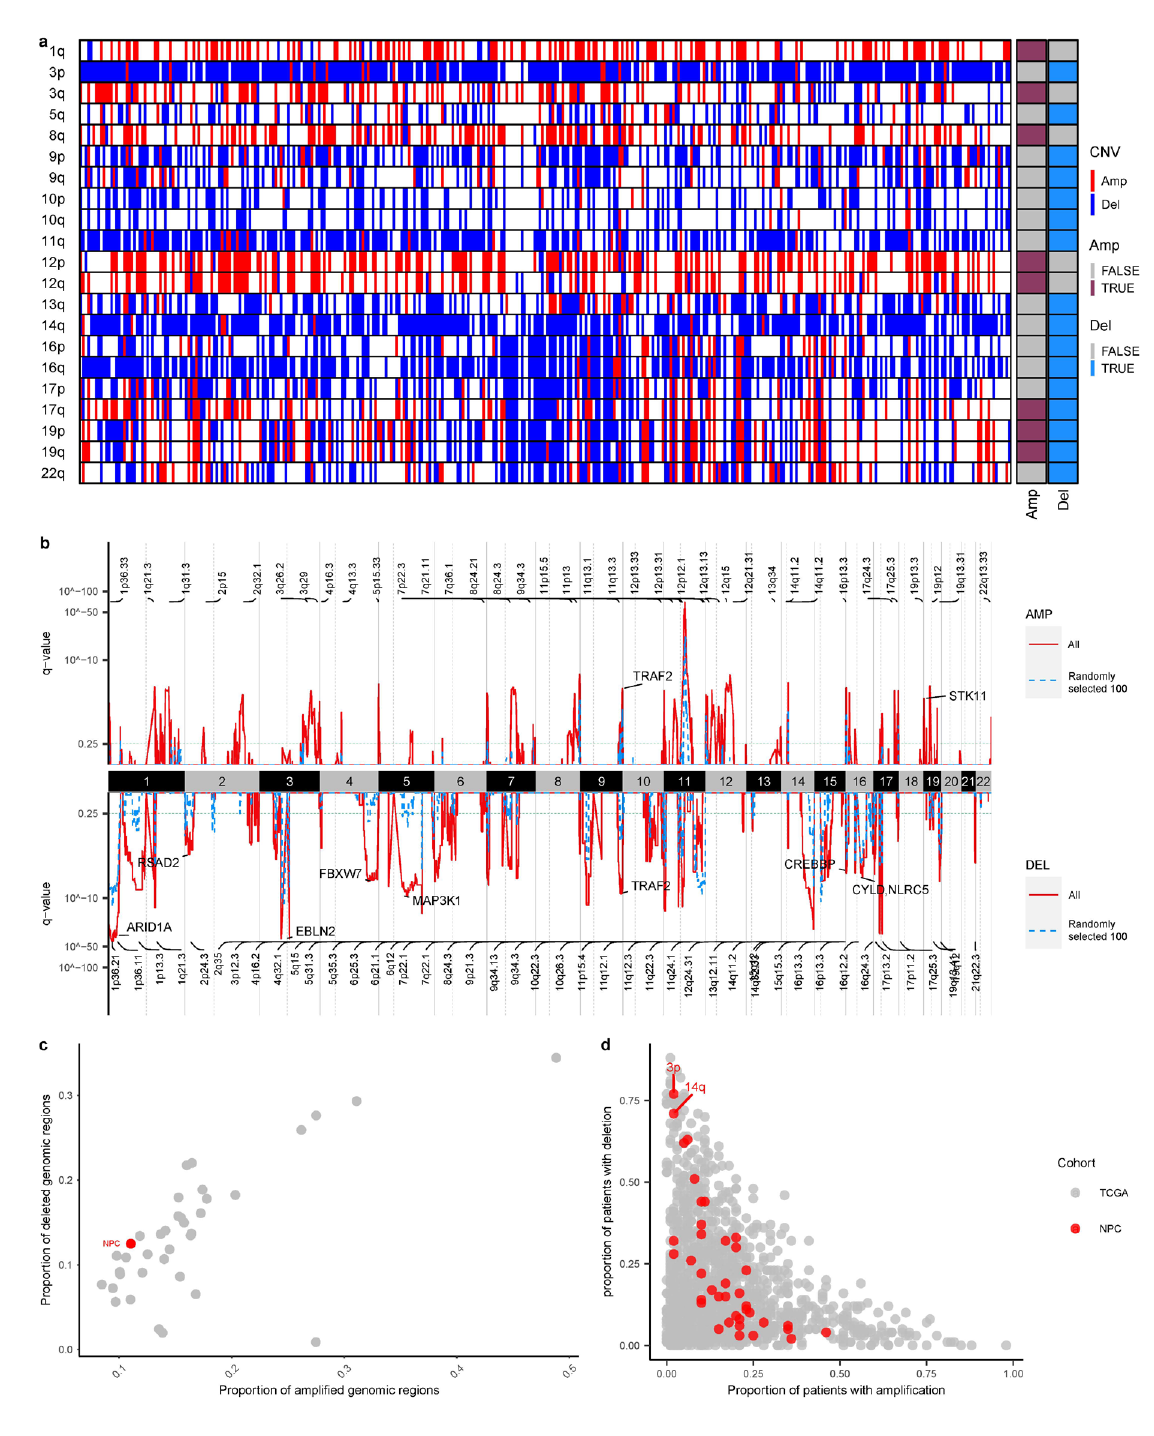
Figure 3. Copy number landscape of the NPC cohort. ( a ) Significant chromosomal CNV changes in the NPC cohort (GISTIC results, Methods). ( b ) Significant focal CNV events identified in the full cohort (all) and randomly subsampled 100 patients (“Randomly selected 100”). Amplifications were plotted on the top; deletions were shown in the bottom. ( c ) Proportion of amplified genomic regions vs. proportion of deleted genomic regions across the TCGA and NPC cohort was plotted. Each dot represents a tumor type. ( d ) For each chromosomal arm, the proportion of patients with amplification (x-axis) vs. proportion of patients with deletion (y-axis) were plotted for all the TCGA and NPC cohorts. Each dot represents a chromosomal arm in a specific tumor type. NPC was shown in red.